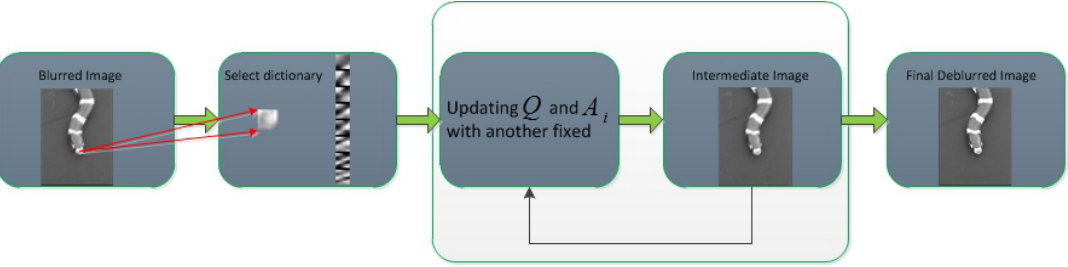
Figure 2. Main step of the proposed